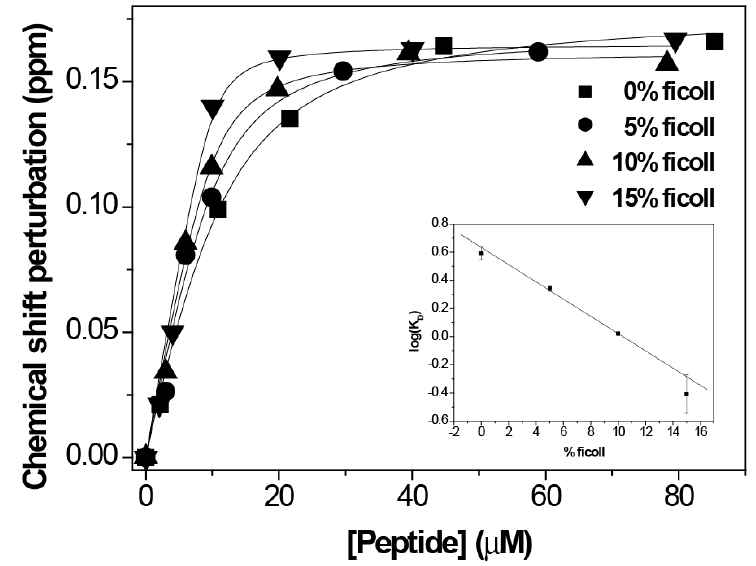
Figure 3. NMR analysis of the binding of PHD to histone H3K4me3 in the presence of different amounts of Ficoll 70. The CSP of the W237 amide resonance of 1 H- 15 N-HSQC spectra of ING4 PHD is represented against the peptide concentration for each titration. The continuous lines are the fittings to the binding model. The height of the symbols corresponds with the experimental error of the measurements. Inset, log K D versus % of Ficoll 70.